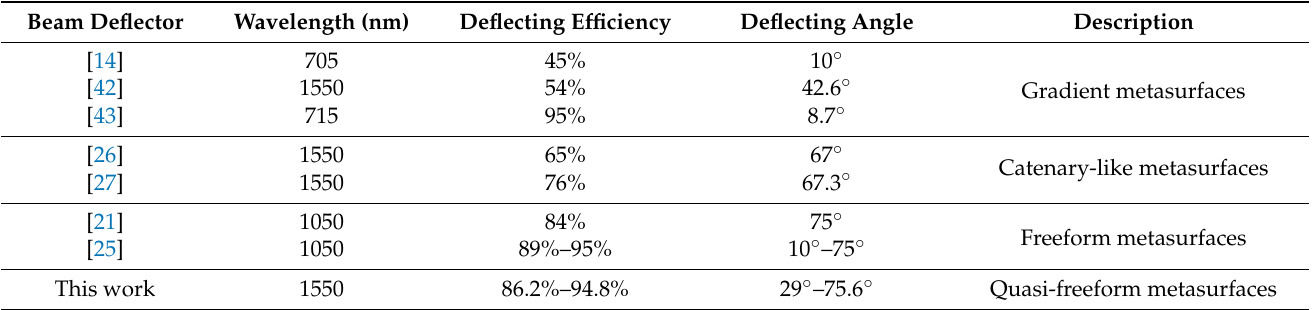
Table 1. Performance comparison of our work and some recent reported